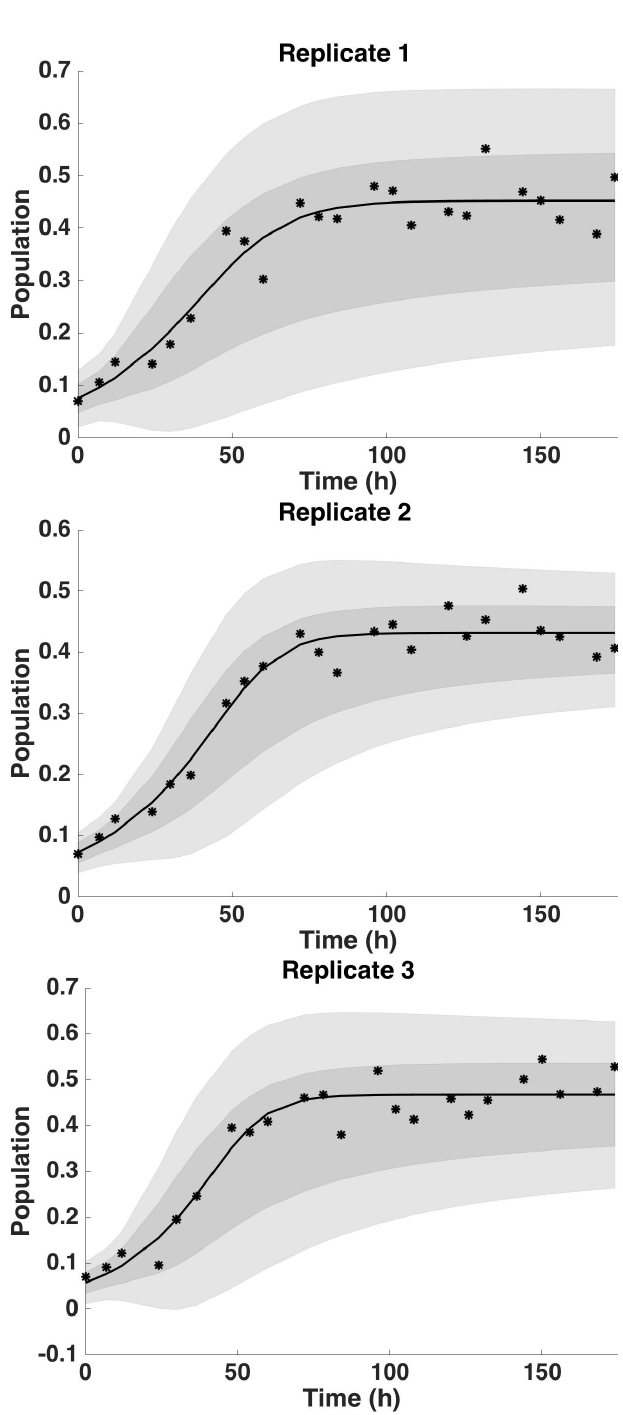
Figure 4. Plots of forward solutions for the Bernoulli curve for the three replicates of the data. Replicate one is on top and three is on the bottom.The lighter and darker shades of grey represent the 95% and 68% confidence bars on the model solution, respectively. The algae population is represented as cells × 10 7 /L. Data points are shown as